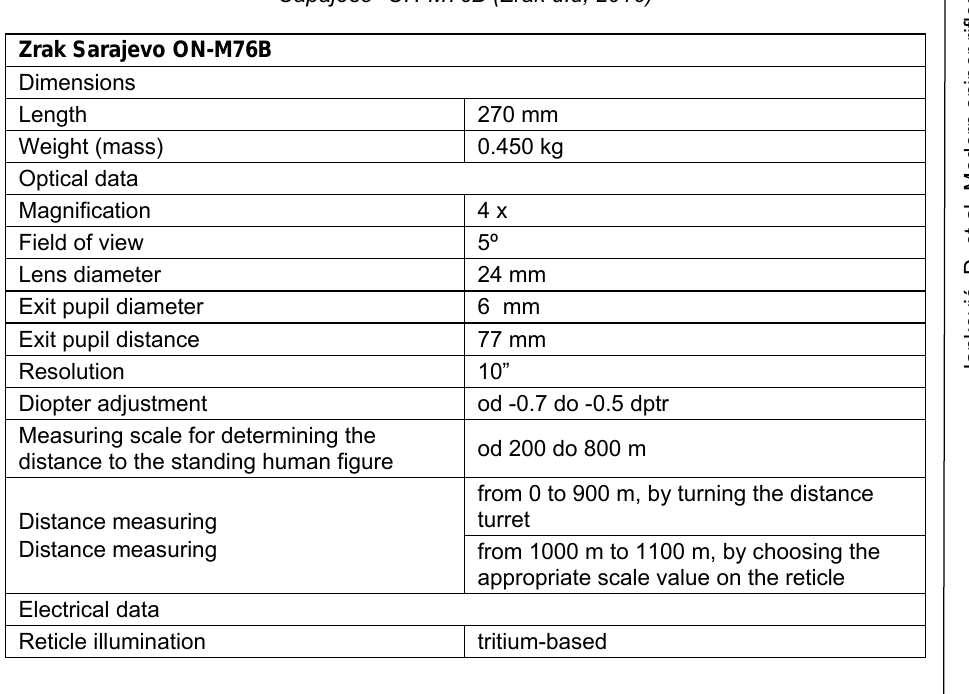
Figure 5 – Optical sight M76B (P.A. Distributing, 2018) Рис . 5 – Оптический прицел М 76 Б (P.A. Distributing, 2018) Table 1 – Technical-technological characteristics of the Zrak Sarajevo ON-M76B optical sight (Zrak d.d, 2016) Таблица 1 – Технико - технологические характеристики оптического